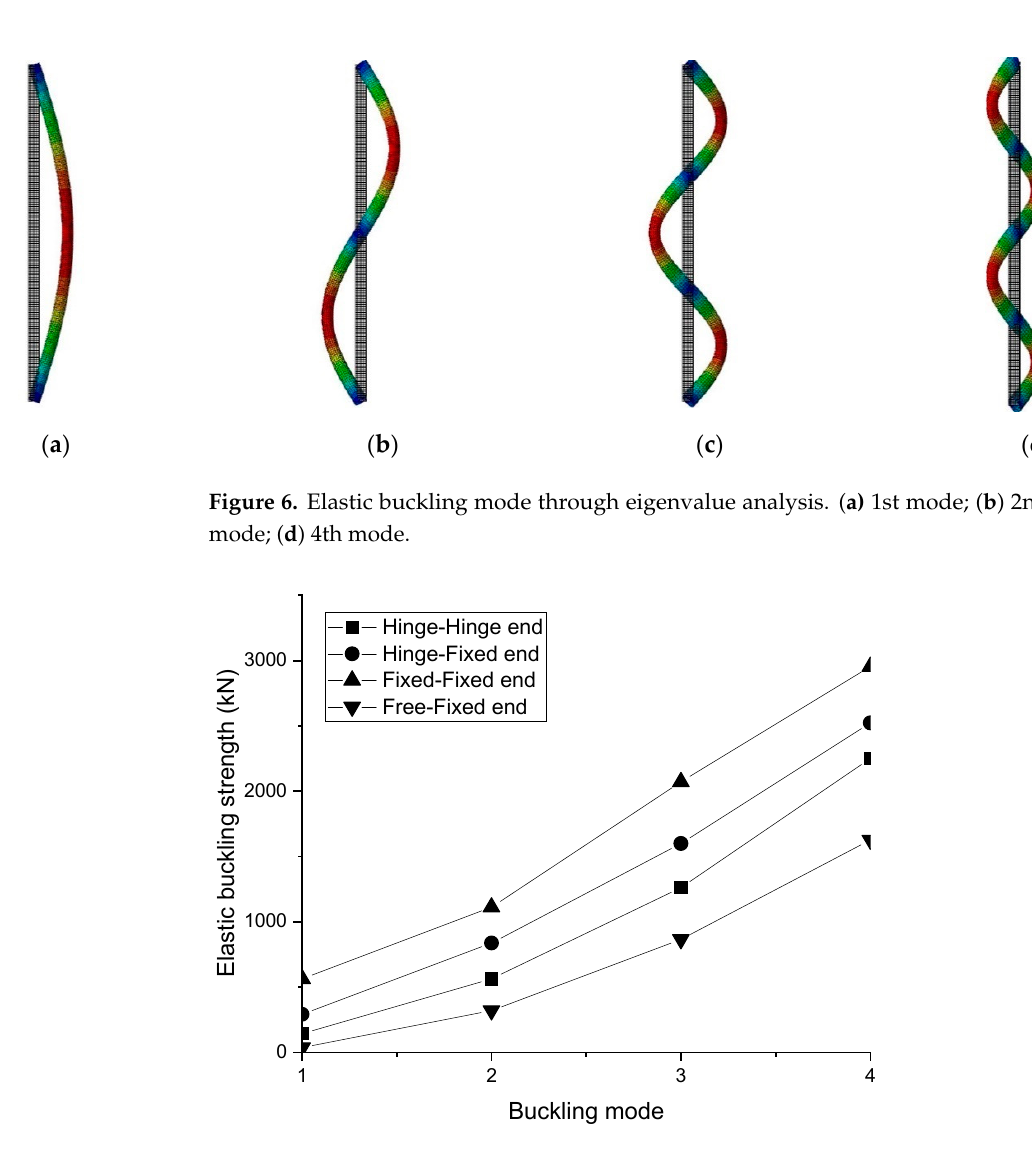
Figure 7. Comparison of buckling strength for each end boundary condition.